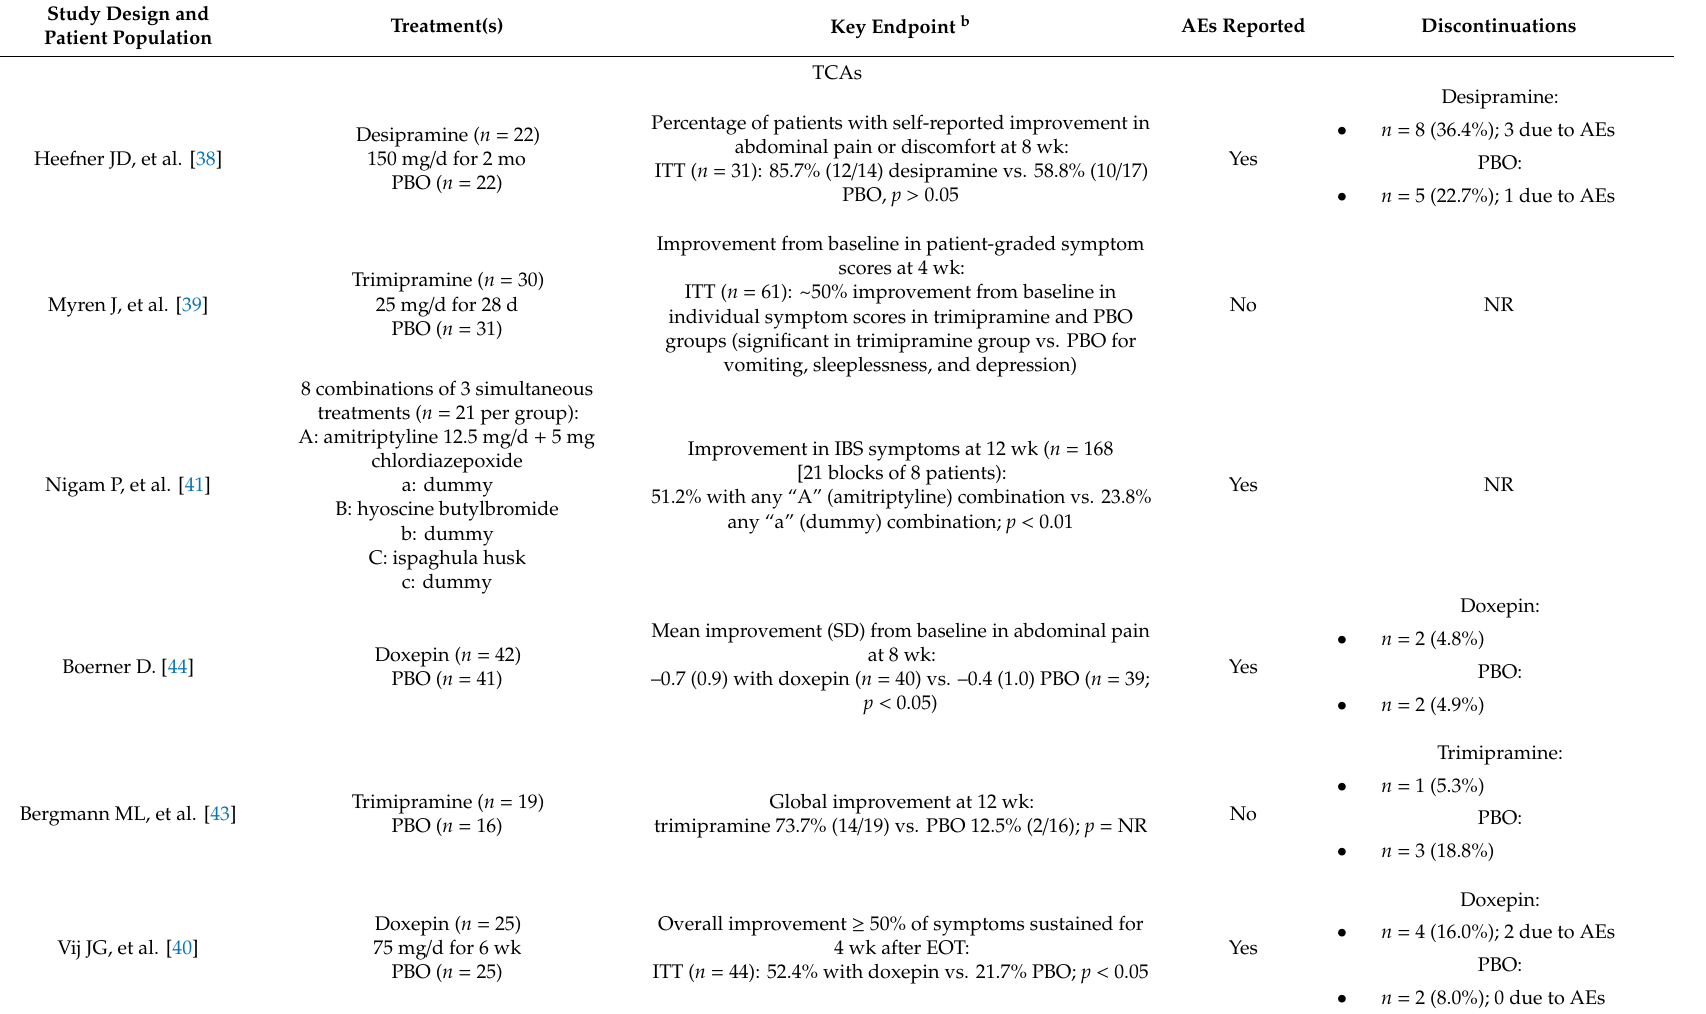
Table 1. Summary of clinical studies of antidepressants in patients with irritable bowel syndrome a